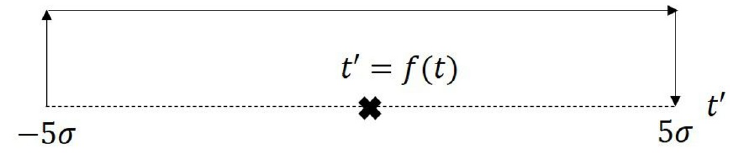
Figure 12 . The modi(cid:12)ed contour used for harvesting calculations in this paper. The contour e(cid:11)ectively does away with (cid:12)nding the poles for derivative Wightman functions. harvesting the nonlocal term M depends on two di(cid:11)erent radial coordinates with di(cid:11)erent gravitational redshifts, so f is highly